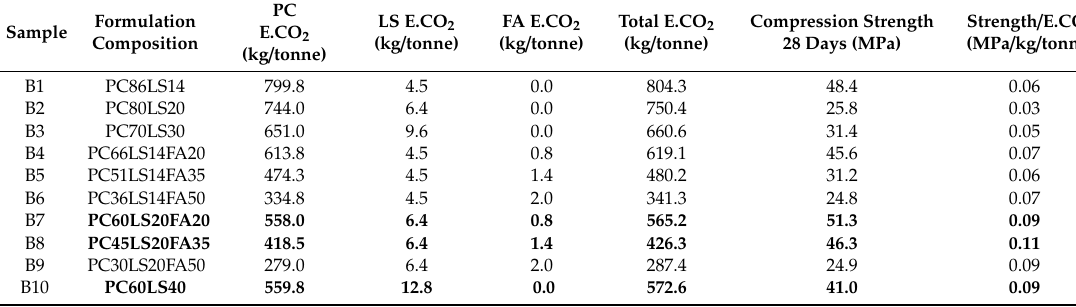
Table 6. Embodied CO 2 associated with strength of binary & ternary cementitious matrices.